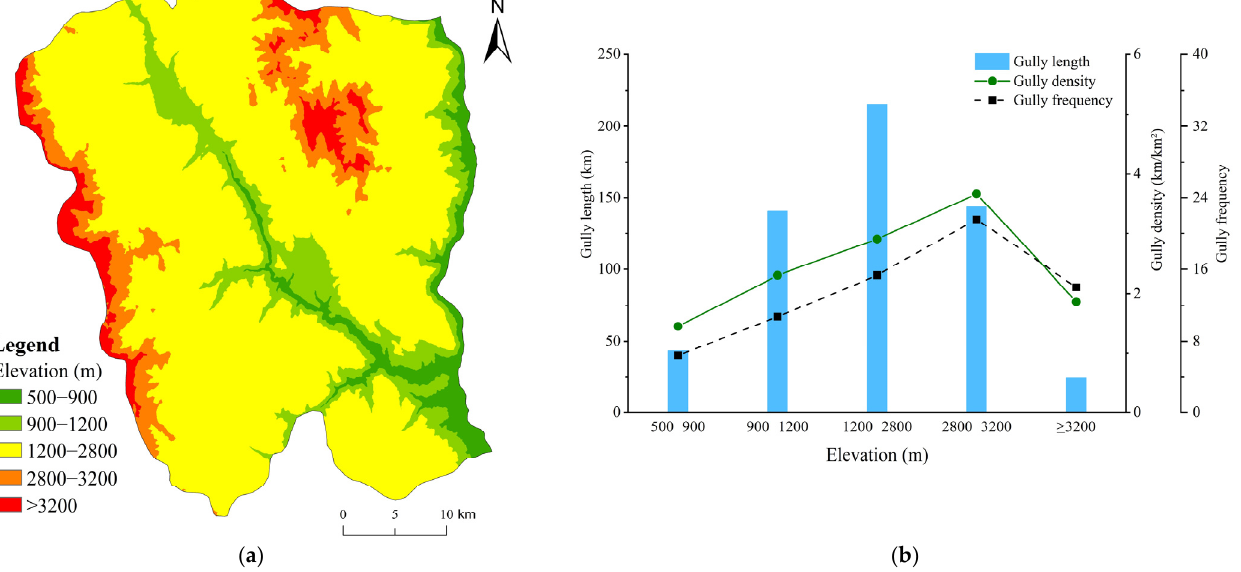
Figure 4. ( a ) Distribution of reclassified elevation ranges; ( b ) Characteristics of gully system parameters (gully length, density, and frequency) under different elevation ranges.